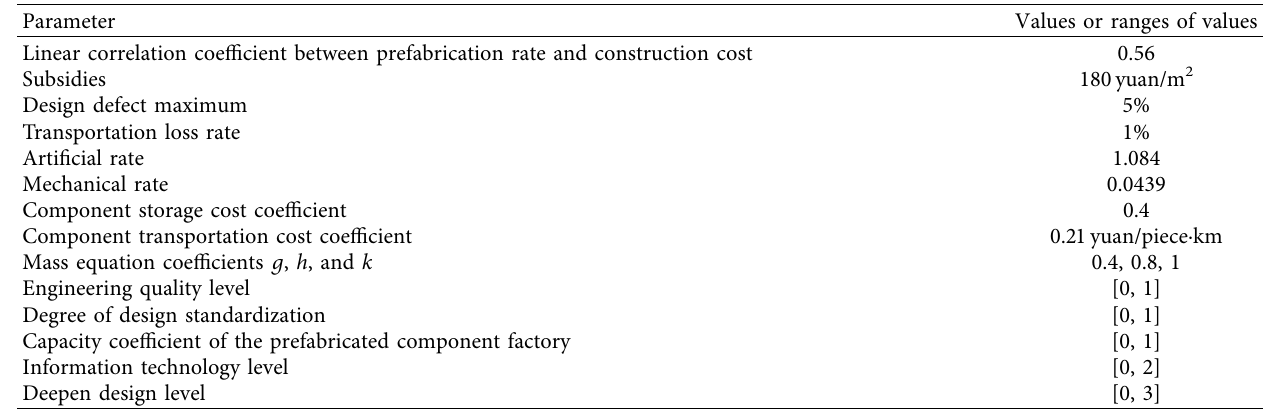
Table 2: Basic equation parameters.